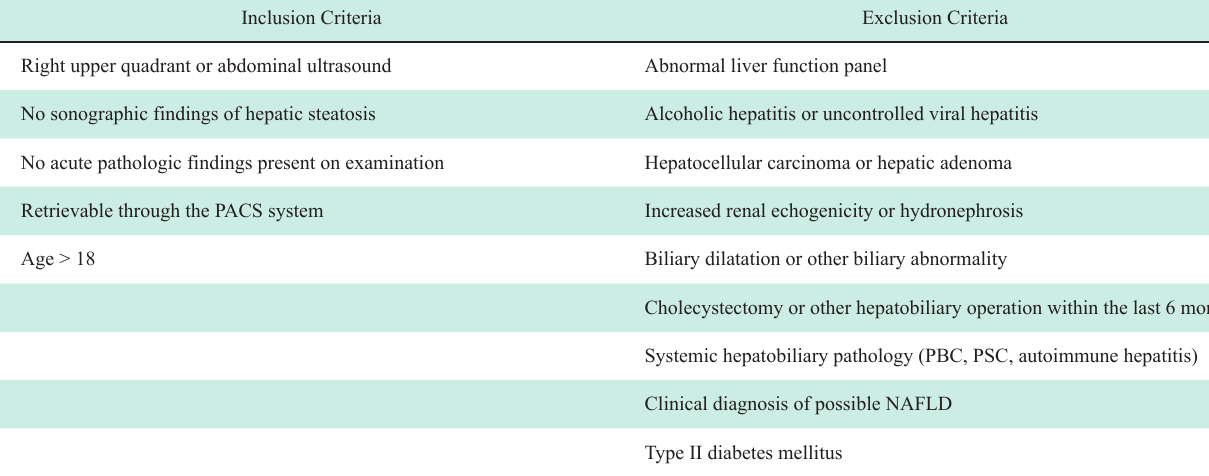
Table 2 Inclusion and exclusion criteria for patients within the “Not Fatty Liver” label Inclusion